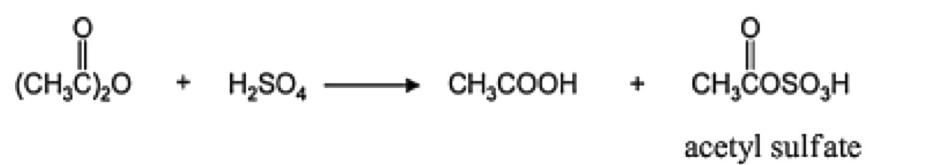
Figure 2. the reactions involved in the homogeneous sulfonation of PS.